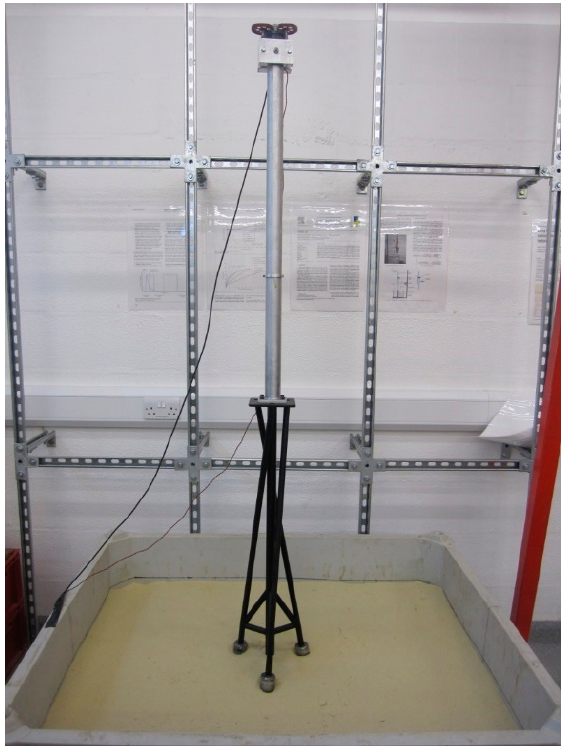
Figure 17. Jacket on slender piles (Surrey Advanced Geotechnical Engineering Laboratory) using Type 3 modelling. Type 3